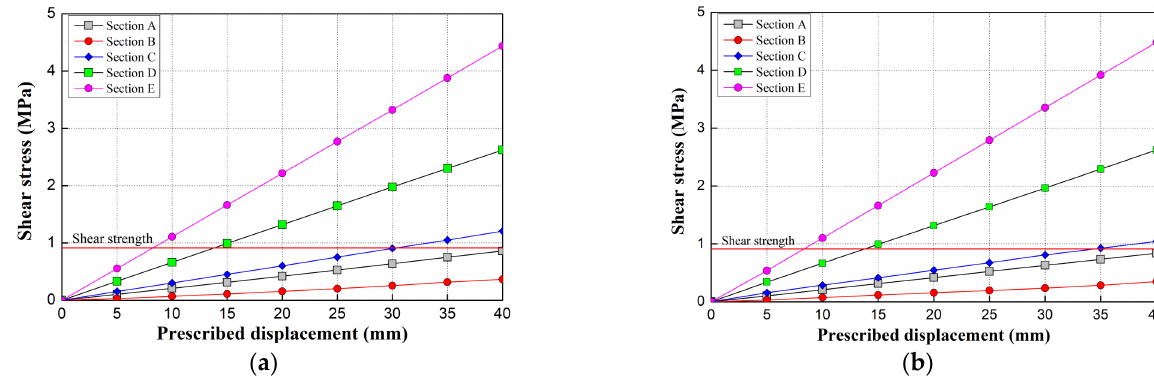
Figure 13. FE analysis results (shear stress, xz direction) according to magnitude of ( a ) uplift or ( b ) subsidence.